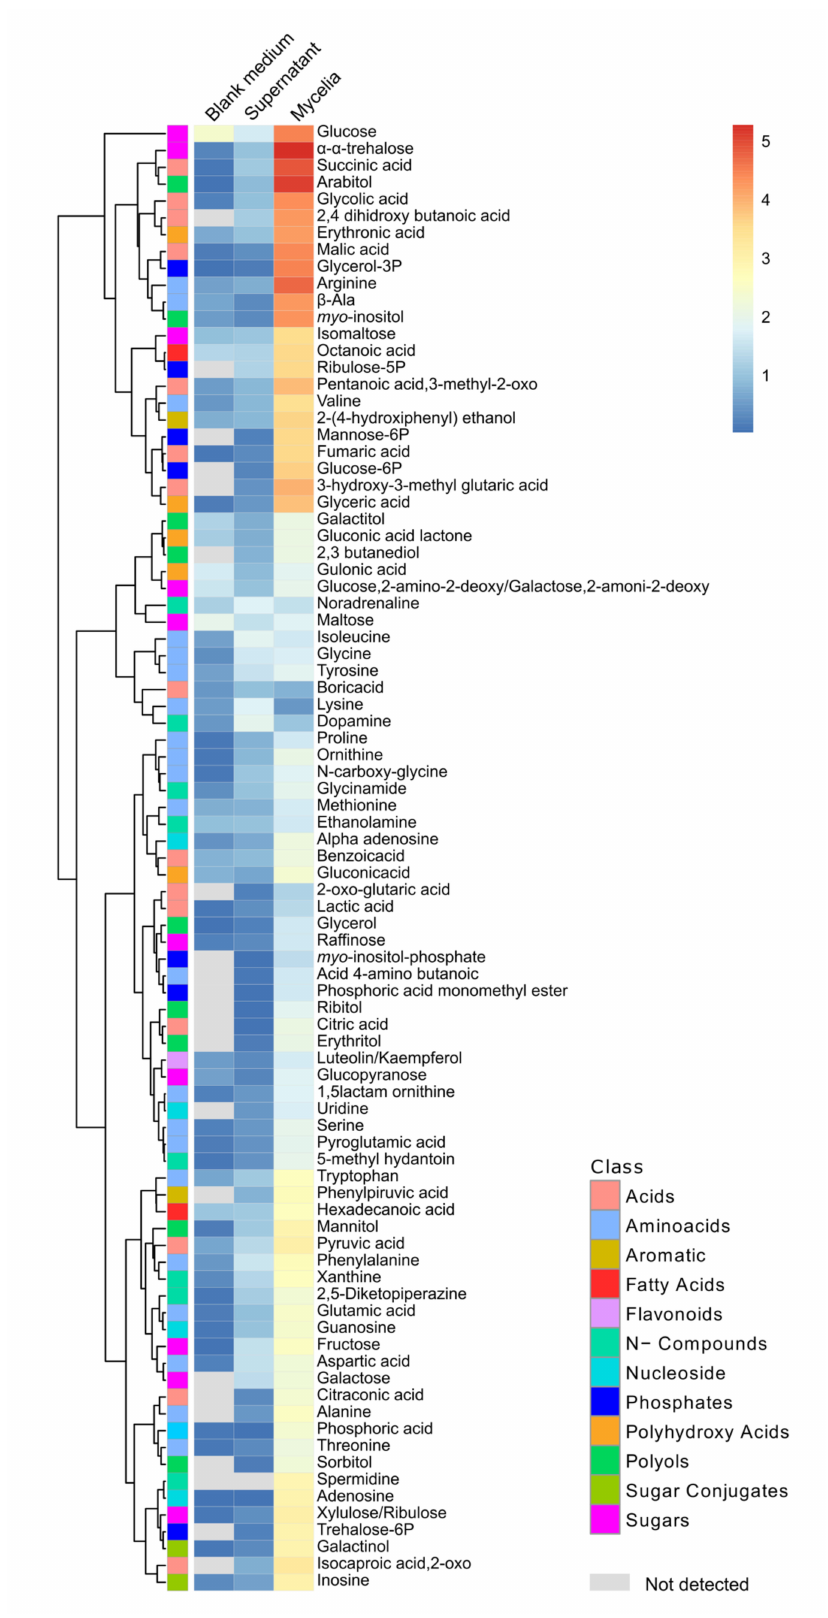
Figure 5. Relative concentration of metabolites detected in mycelia and the supernatant of Fusarium solani 142L52B after 7 days of incubation at 28 ◦ C in Sabouraud broth (SAB). Relative concentration of metabolites expressed as the average of the normalized values to the median and corrected by non-sample controls ( n =